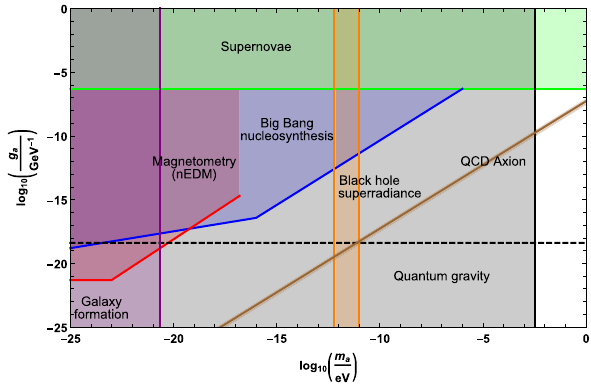
Fig. 2 Parity conserving quantum gravity. Limits on the linear axion interaction g a = c 3 /(cid:4) 3 as a function of the mass of the axion m a . Green: limits from supernovae measurements [54]. Blue: limits from the big bang nucleosynthesis [20,55–58]. Red: limits from magnetom- etry experiments [25,45]. Purple: limits from galaxy formation, quasar lensing and stellar streams [48–53]. Orange: limits from the superradi- ance instability of black holes [59], however note that these bounds can beavoided,iftheself-interactionoftheaxion-likeparticleissufficiently strong [60]. Brown: predicted value of the QCD axion [61,62]. Black: axion masses below m a (cid:3) 10 − 21 eV are excluded by parity conserving quantum gravity as discussed in this paper. Dashed black line: reduced Planck scale